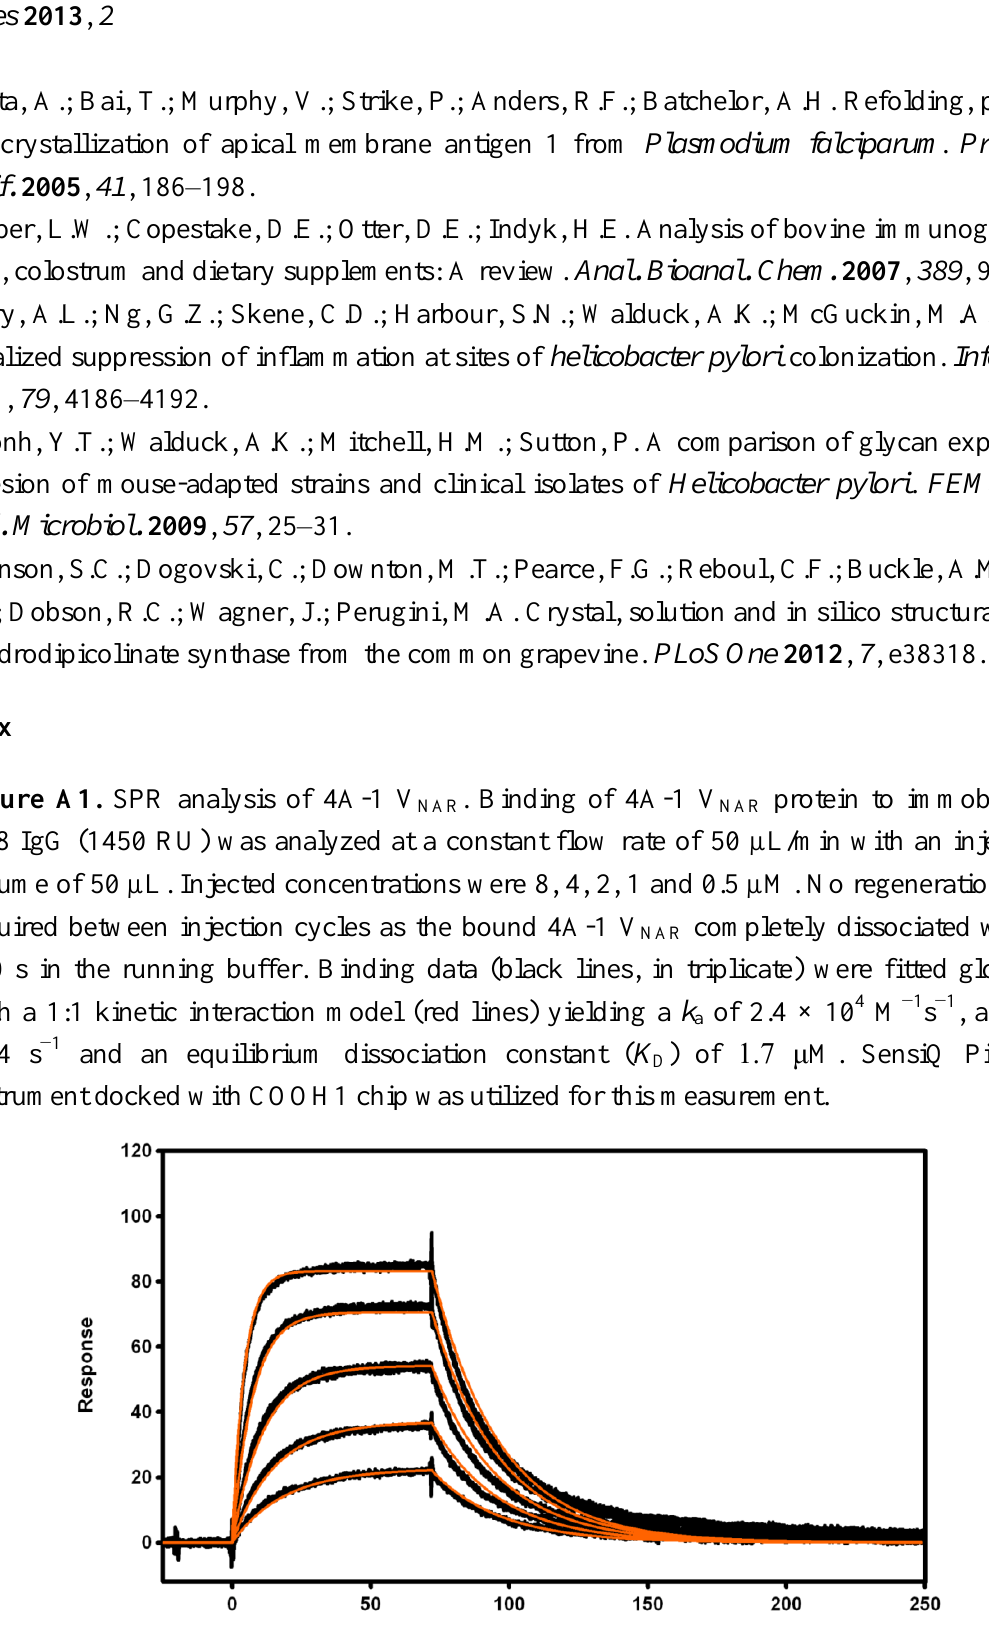
. Binding of 4A-1 V protein to immobilized NAR NAR completely dissociated within NAR of 2.4 × 10 4 M −1 s −1 , a k of a d ) of 1.7 μM. SensiQ Pioneer D